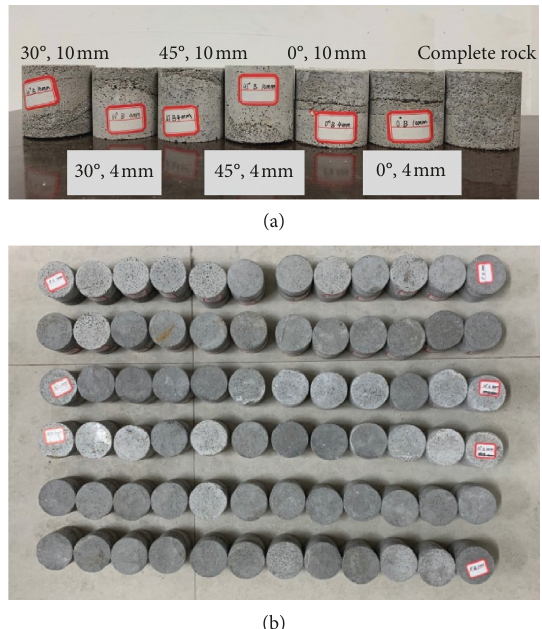
Figure 2: Shape after processing the specimen.